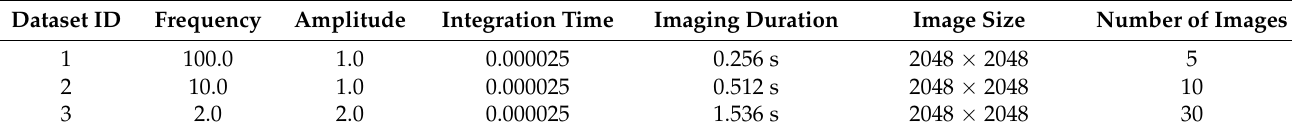
Table 1. Basic information of the simulated